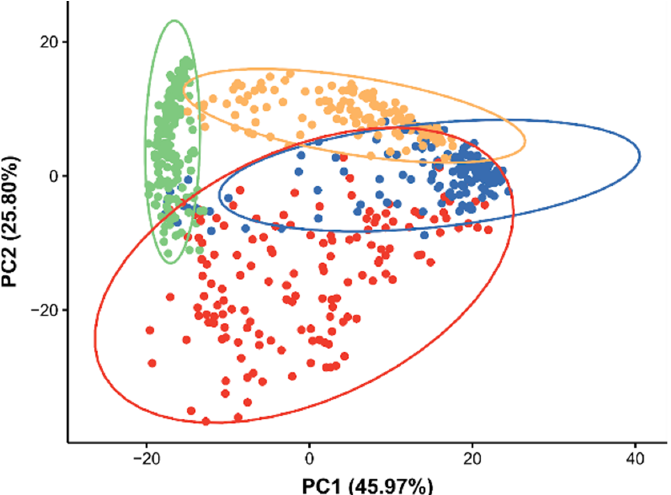
Figure 3. PCA scores plot from analysis of the DESI-MS dataset of four distinct tissues types in Daphnia magna , illustrating the differences in the baseline lipidomes of the appendages (blue), eggs (yellow), eye (green), and the gut (red). Each point relates to a single pixel from a DESI-MS ion image of D. magna .